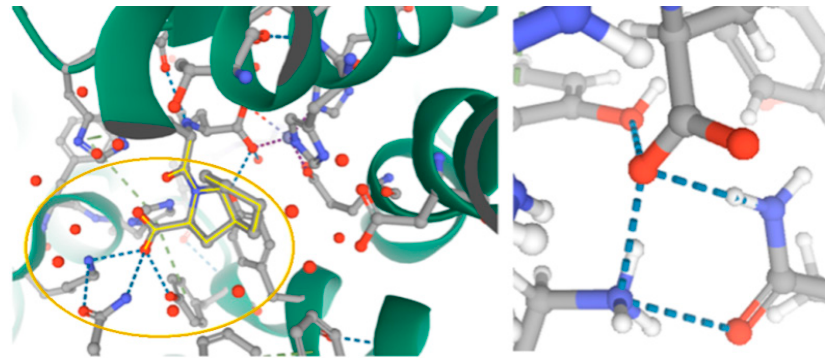
Figure 11. Proline-based synthons in bio-complexes of ACE with perindoprilat, 2x94.pdb (proline moiety is marked by orange colour) [205]—on the left, and fosinoprilat, 6s1z.pdb [206]—on the right.